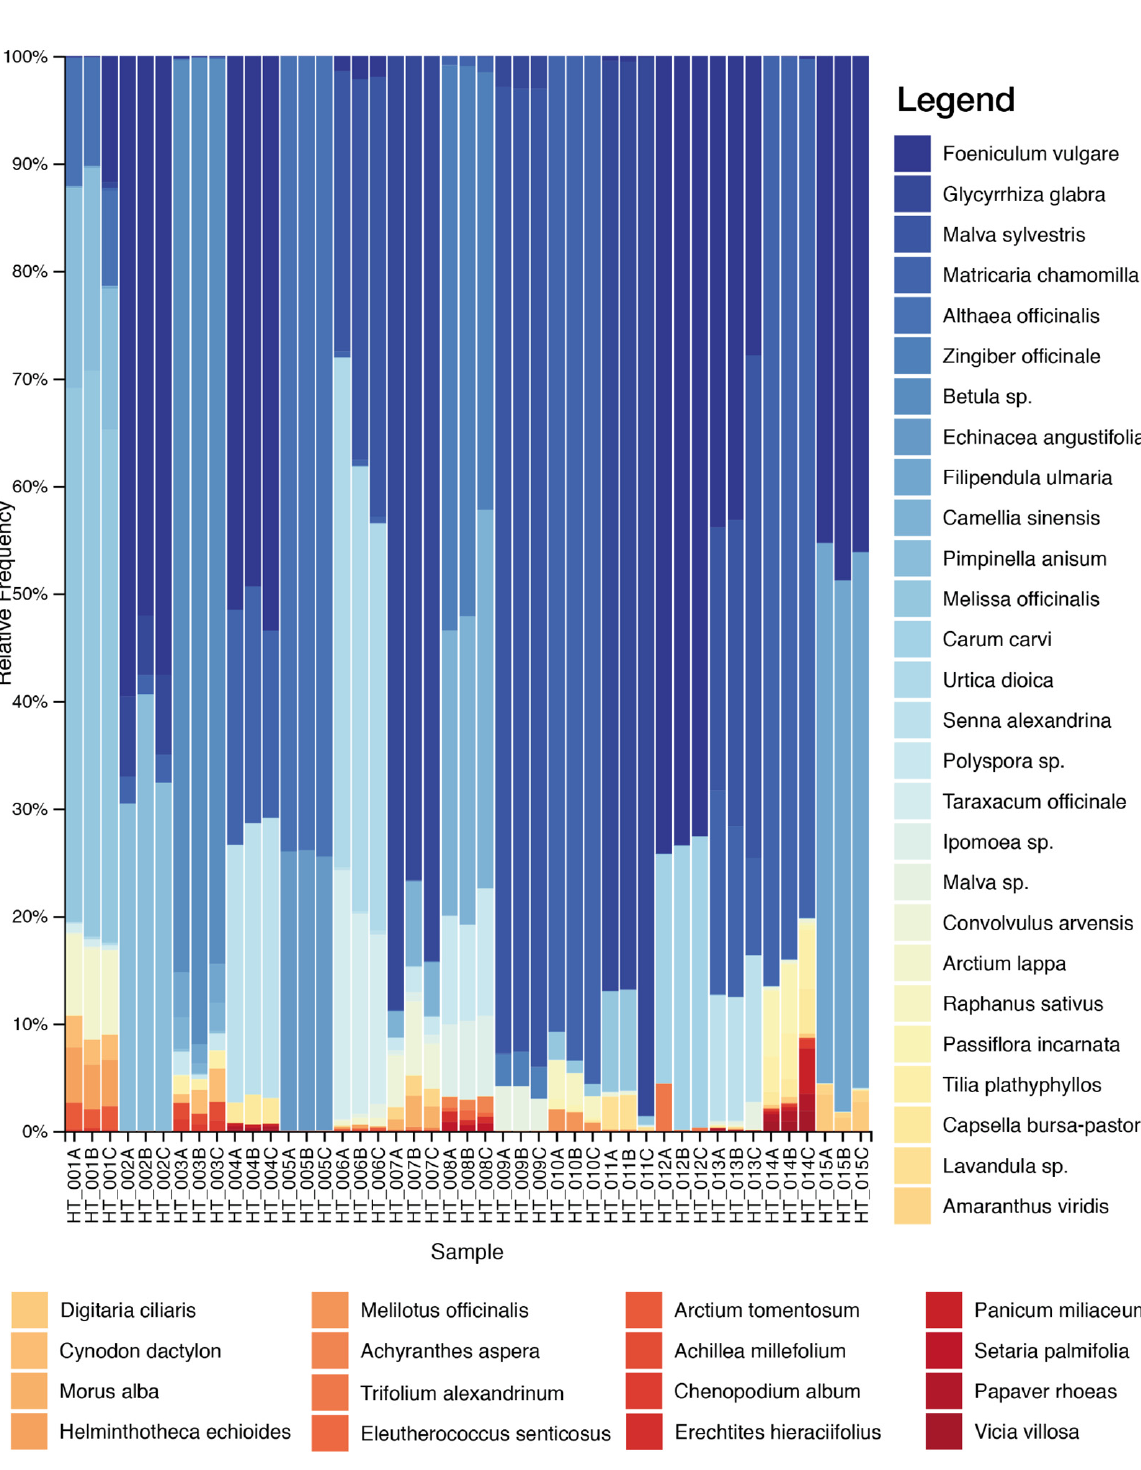
Figure 1. Relative abundance of the plant taxa recovered in the 15 herbal tea products through ITS2 metabarcoding sequencing. Only the taxa present in at least two of the three replicas and in a concentration >1% are shown. The complete list of taxa is reported in Supplementary Table S1.